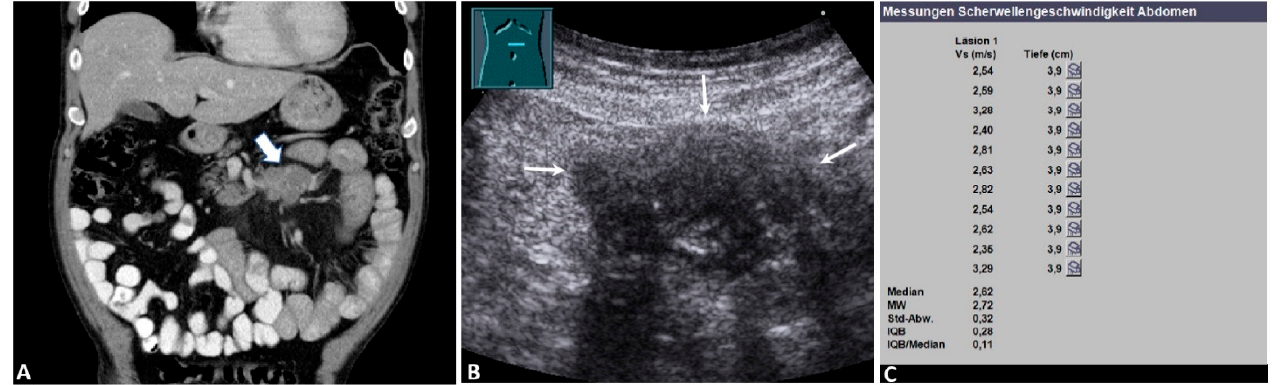
Figure 2. Malignant mesenteric mass. A 67-year-old male patient with a known history of malignant lymphoma and suspected recurrence on staging. ( A ) Computed tomography showing a hypointense round mass in the left upper quadrant (arrow) (courtesy of Prof. Dr. Mahnken, Department of Radiology, University Hospital Marburg); ( B ) B-mode ultrasound showing a hypoechoic mesenteric mass (arrows); ( C ) the final acoustic radiation force impulse (ARFI) report of the same mass, showing a mean ARFI velocity (MW) of 2.72 m/s. The mesenteric histology showed a high-grade malignant lymphoma. Läsion 1: lesion 1; Vs (m/s): velocity in meter per second; Tiefe (cm): depth in centimeter; MW = mean value (Mittelwert); Std-Abw.: standard deviation (Standard Abweichung); IQB = interquartile range (Interquartilbereich).